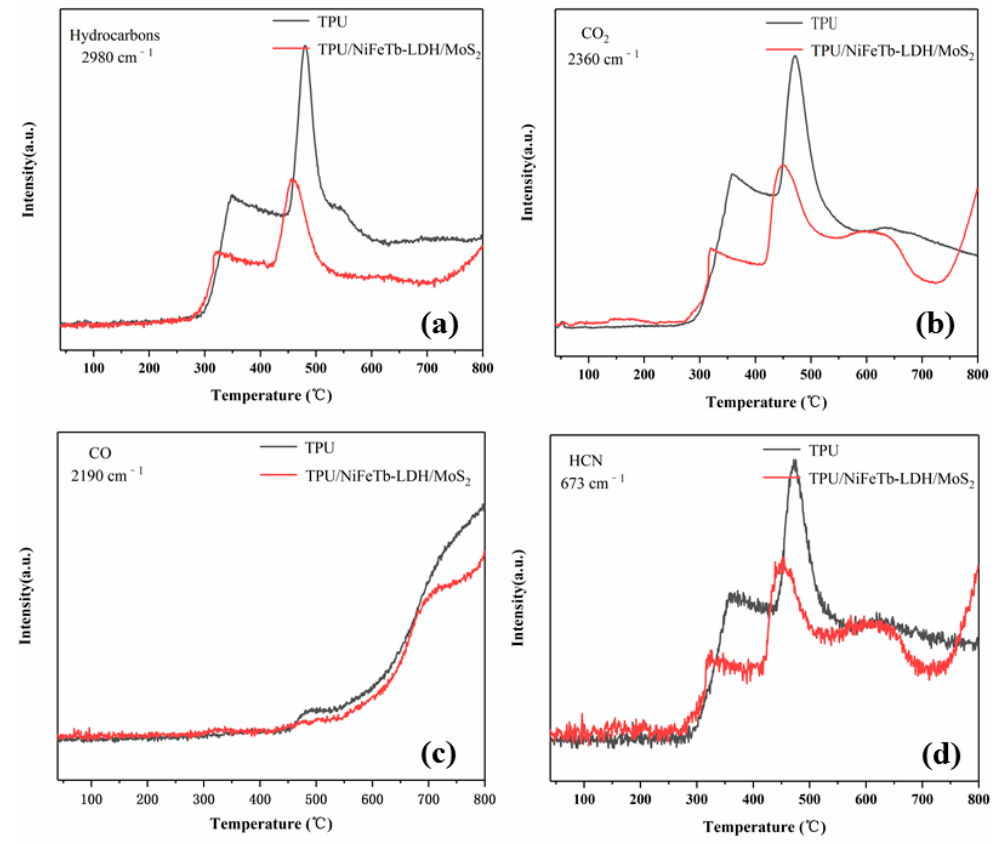
Figure 14. The absorbance intensities of Hydrocarbons ( a ), CO 2 ( b ), CO ( c ) and HCN ( d ) of pure TPU and TPU/NiFeTb-LDH/MoS 2 .